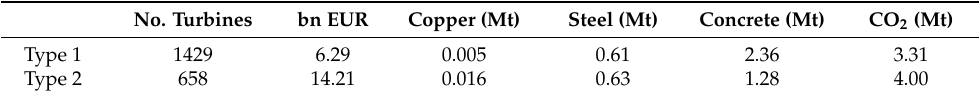
Table A4. Demand for green hydrogen (14 TWh) in terms of onshore/offshore turbines. No. Turbines